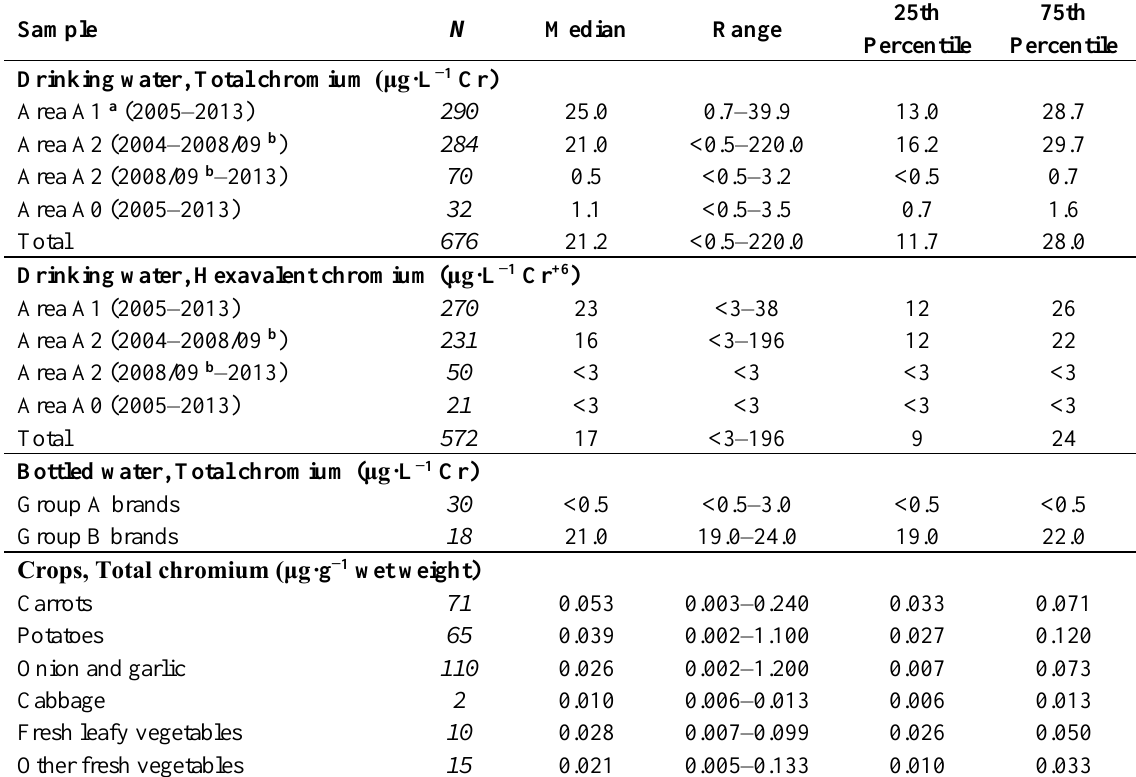
Table 1. Chromium concentrations in environmental samples.